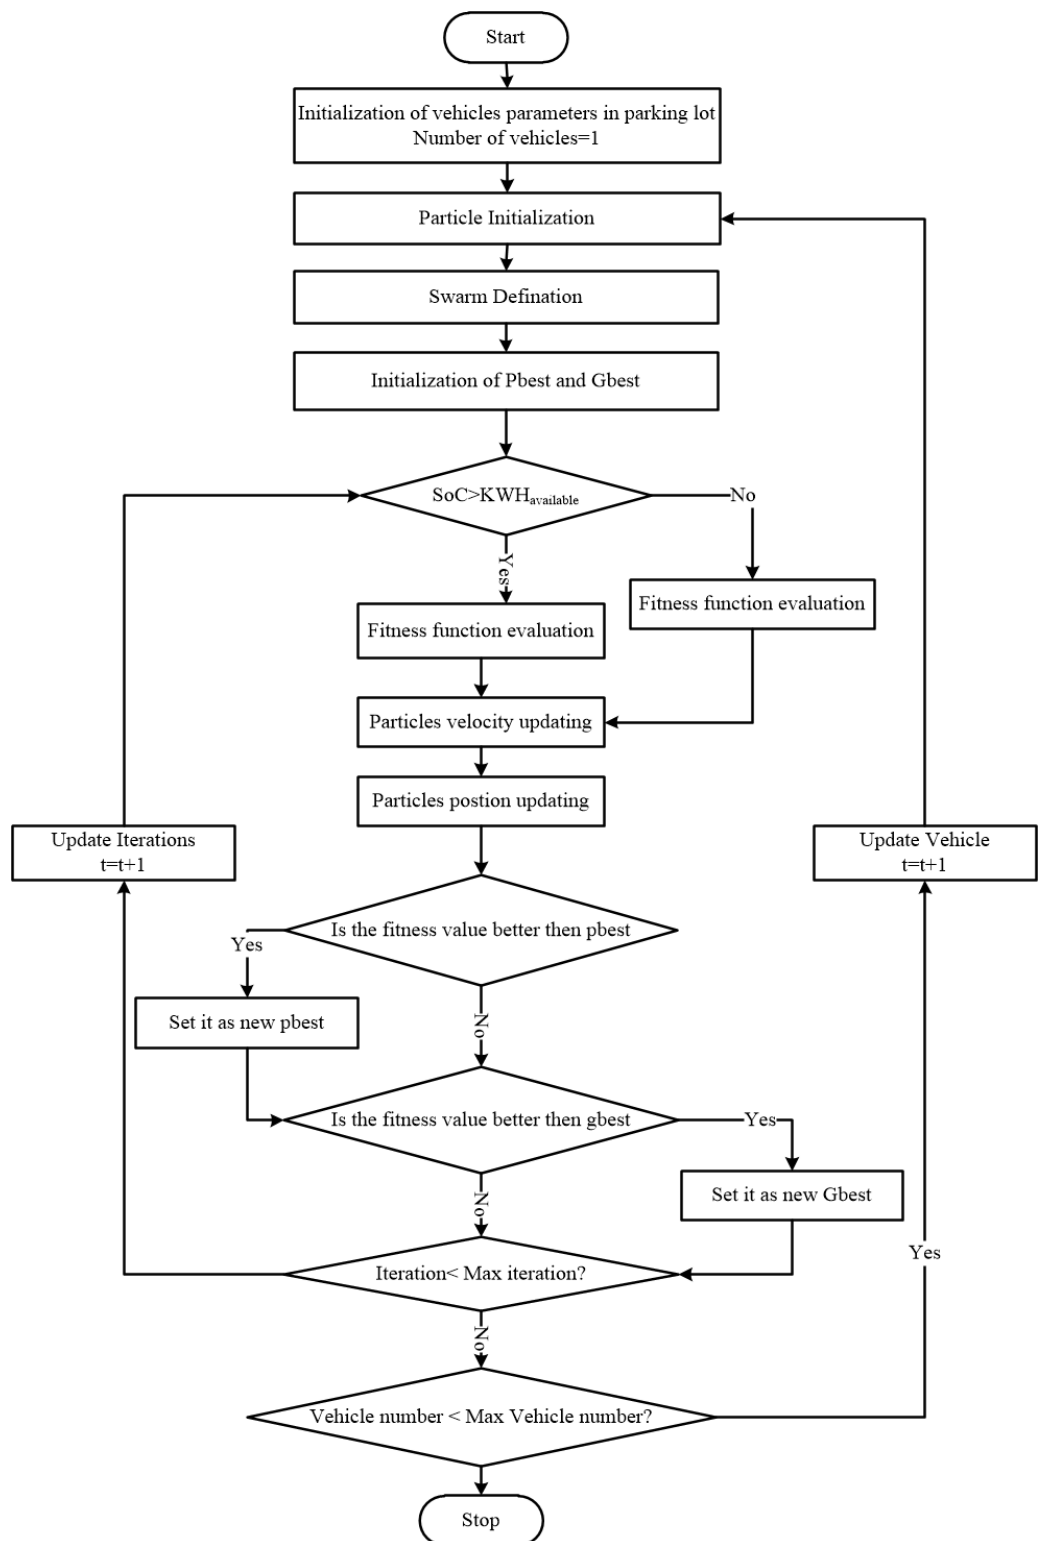
Figure 6. Implementation of particle swarm optimization (PSO) for the optimal selection of power source.